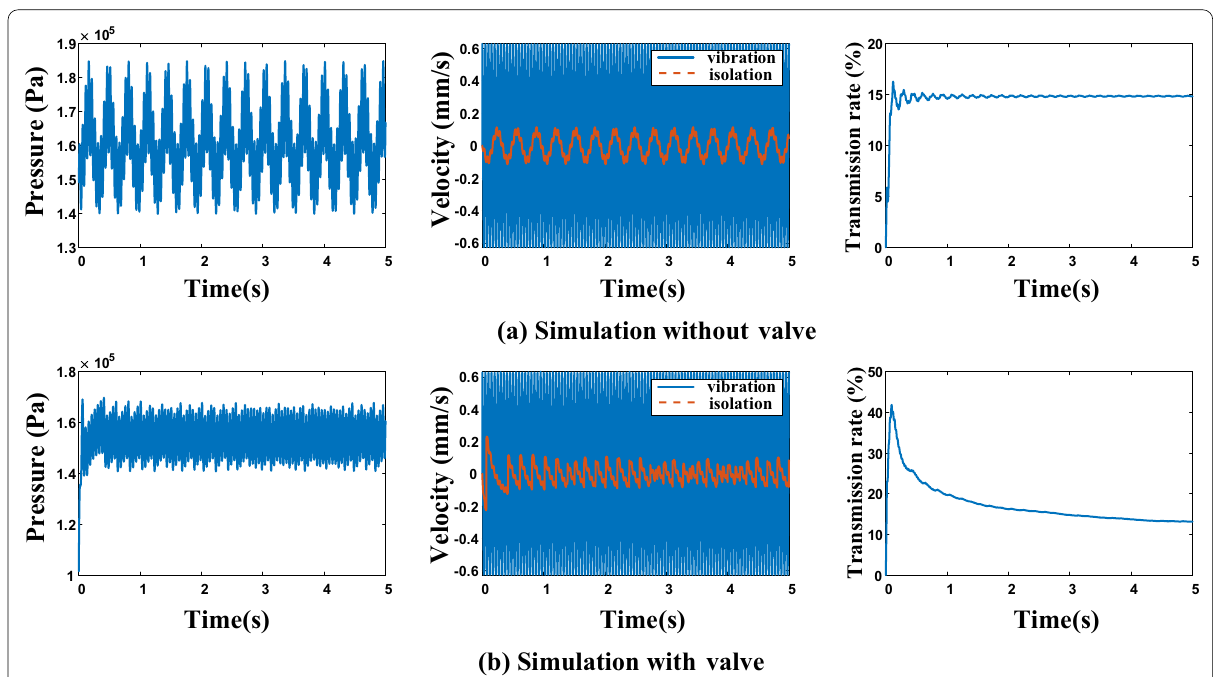
Figure 9 Simulation results comparison of pressure, velocity and transmission rate under 20 Hz